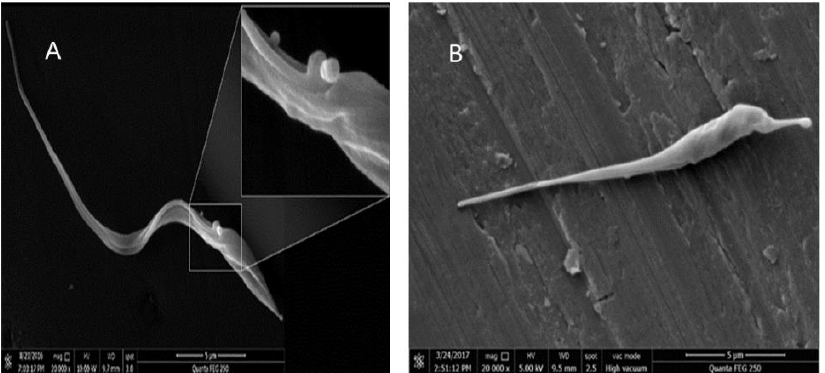
Figure 5. Scanning electron microscopy of the T. cruzi hemoflagellate specimens treated with ergosterol peroxide. ( A ) the left panel is shown at 20,000× magnification, and the top right panel is an image of the same sample but magnified; ( B ) the untreated negative control at 20,000× magnification.